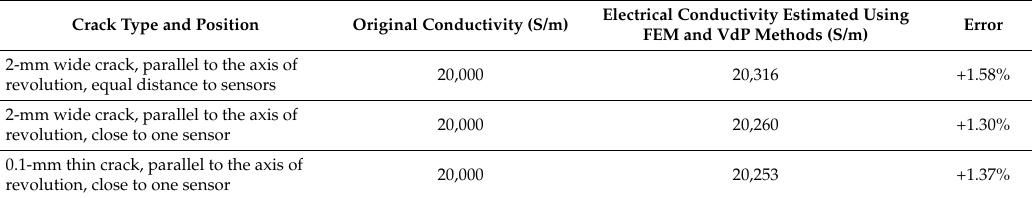
Table 2. Electrical resistivity estimation, using the FEM and VdP methods, for a sample containing a crack parallel to the axis of revolution.